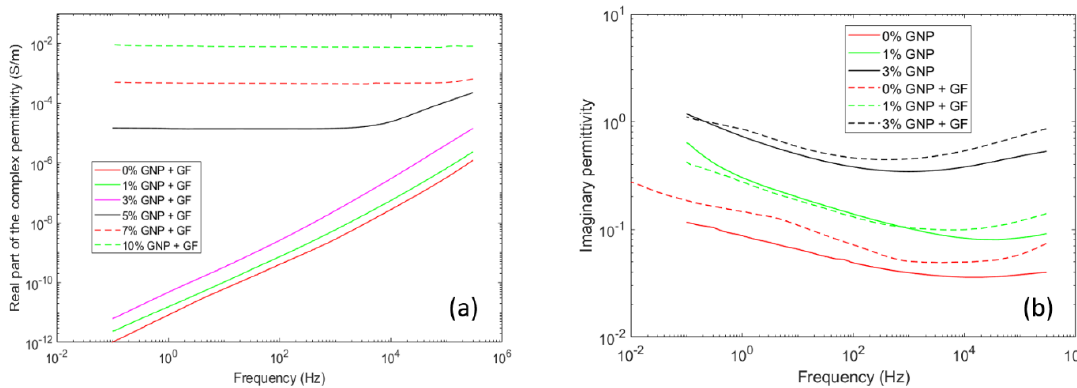
Figure 2. ( a ) real part of the complex conductivity of glass fiber-reinforced (GF) graphene/polyester composites; ( b ) Imaginary part of the permittivity as a function of frequency for the non-percolating composites.